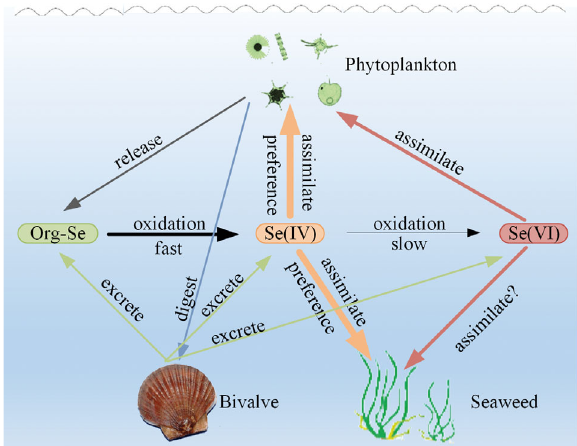
Fig. 5. A conceptual diagram of the biological effects of phytoplankton, seaweed and bivalves on selenium speciation (based on Vandermeulen & Foda 1988, Besser et al. 1994, Hu et al. 1997, Baines & Fisher 2001, present